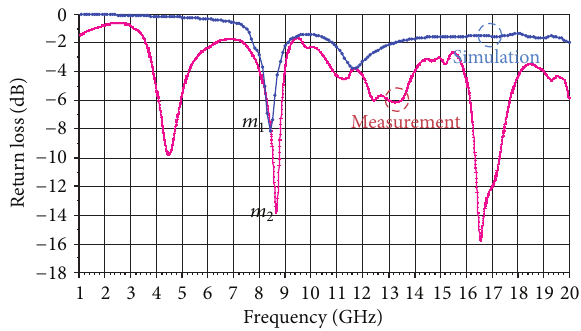
F 12: Simulated and measured return loss versus frequency for the MEMS-MTM antenna when the gap is 30